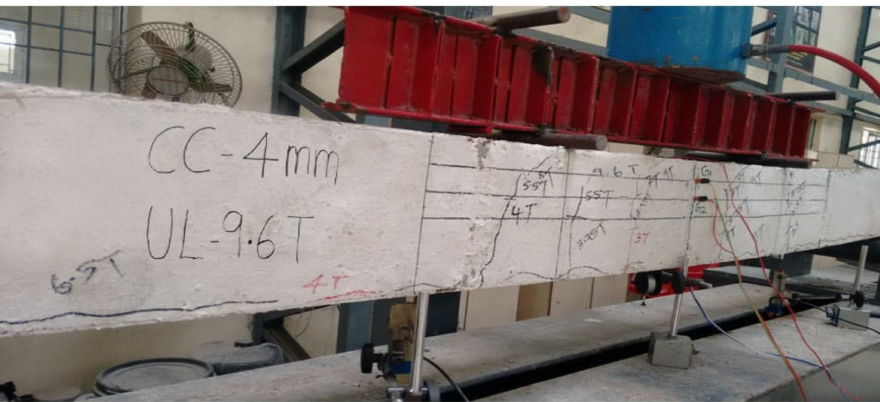
Figure 14. SCS beam with shear studs under flexural test (after testing).